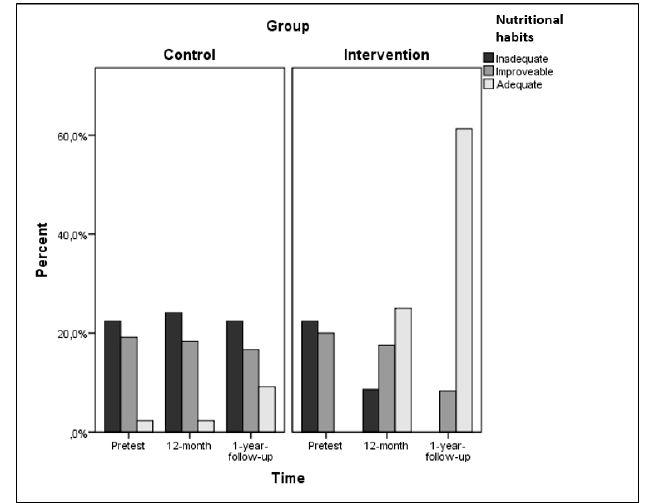
Figure 2. Classification of participants in intervention and control groups into nutritional habit categories.